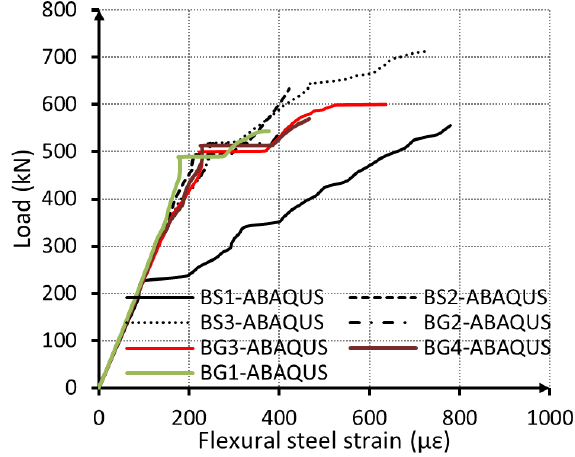
Figure 34: Strain curve for deep beams’ main bar (Tie)